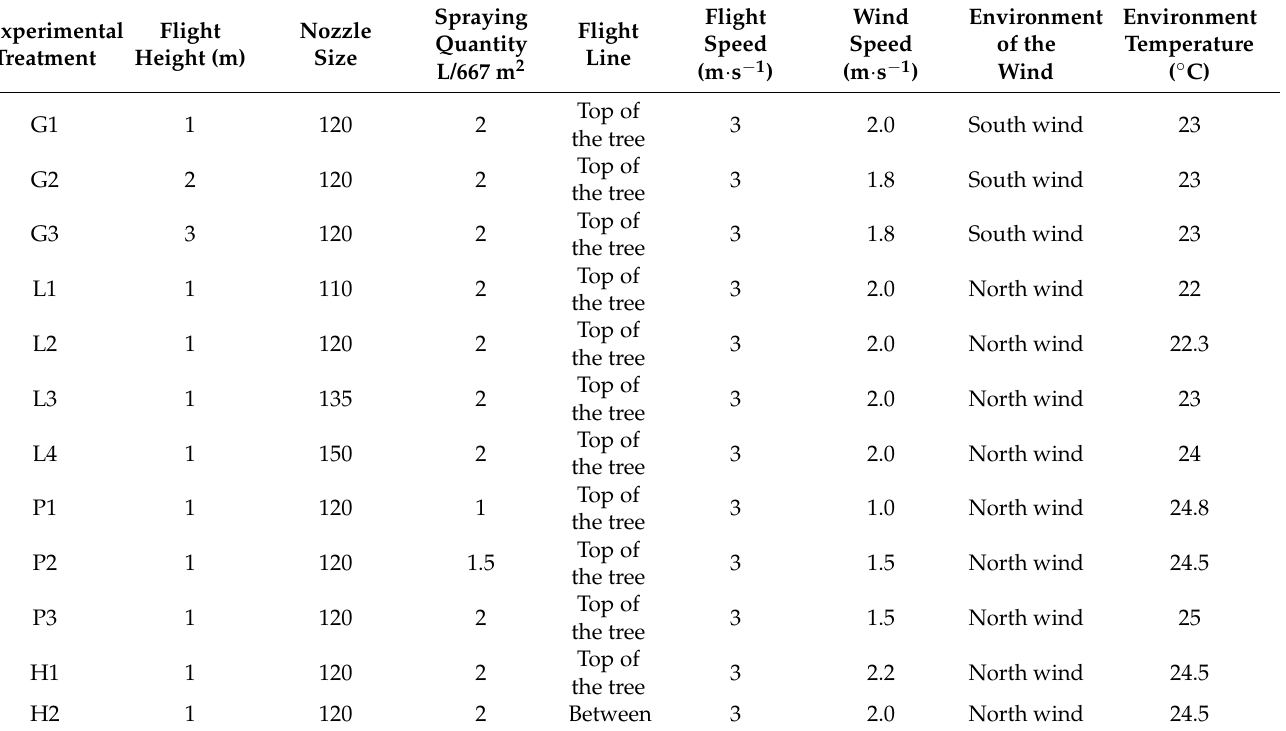
Table 2. UAV operation